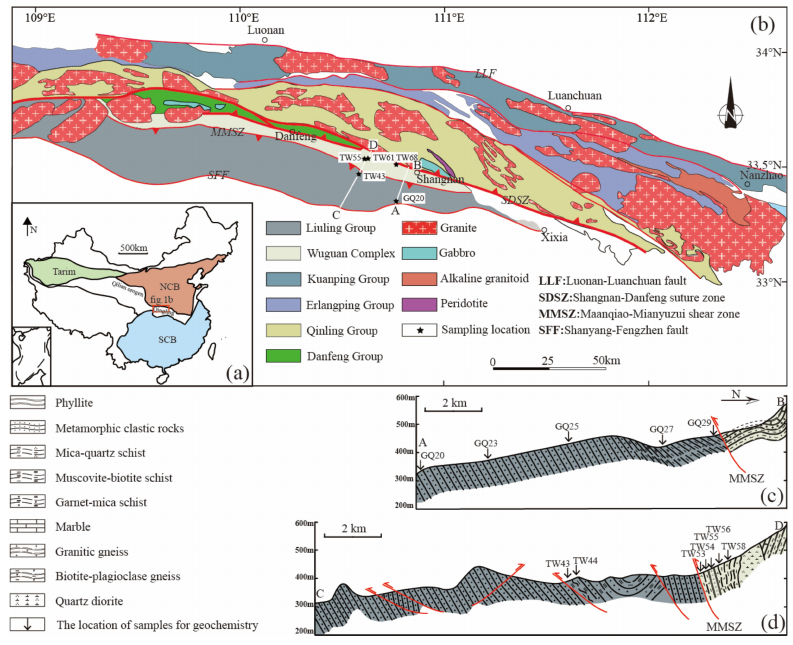
Figure 1. ( a ) The main tectonic divisions in the Chinese mainland, showing the location of the study area (after [32]). ( b ) Simplified geologic map of the eastern Qinling orogen (after [19]) and locations